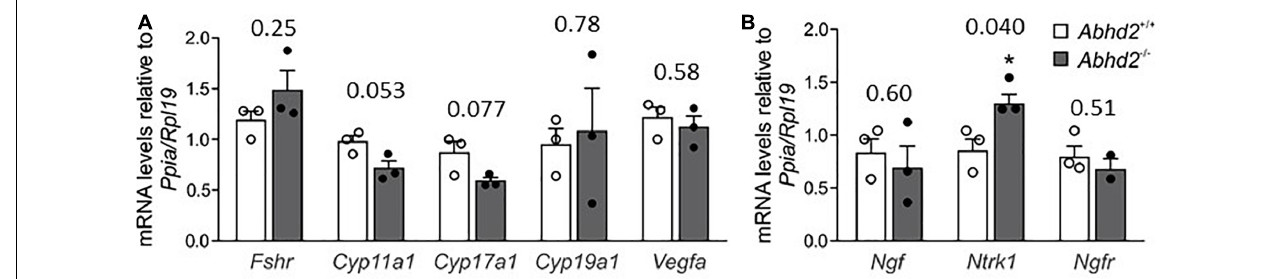
FIGURE 6 | Ovarian gene expression. Relative expression levels of genes involved in steroid synthesis, follicle development and ovulation were measured by qPCR using ovaries of three Abhd2 + / + and three Abhd2 − / − 1-month old superovulated mice. (A) Expression levels were normalized to the expression of ribosomal protein L19 ( Rpl19 ) and peptidylprolyl isomerase A ( Ppia ). Follicle stimulating hormone receptor ( Fshr ), cytochrome P450 family 11 subfamily A member 1 ( Cyp11a1 ), cytochrome P450 family 17 subfamily A member 1 ( Cyp17a1 ), cytochrome P450 family 19 subfamily A member 1 ( Cyp19a1 ), vascular endothelial growth factor A ( Vegfa ), and (B) nerve growth factor ( Ngf ), neurotrophic receptor tyrosine kinase 1 ( Ntrk1 ), and nerve growth factor receptor ( Ngfr ). Statistical significance was calculated using the unpaired t -test, with p -values above columns and the significance of changes indicated as: * p ≤